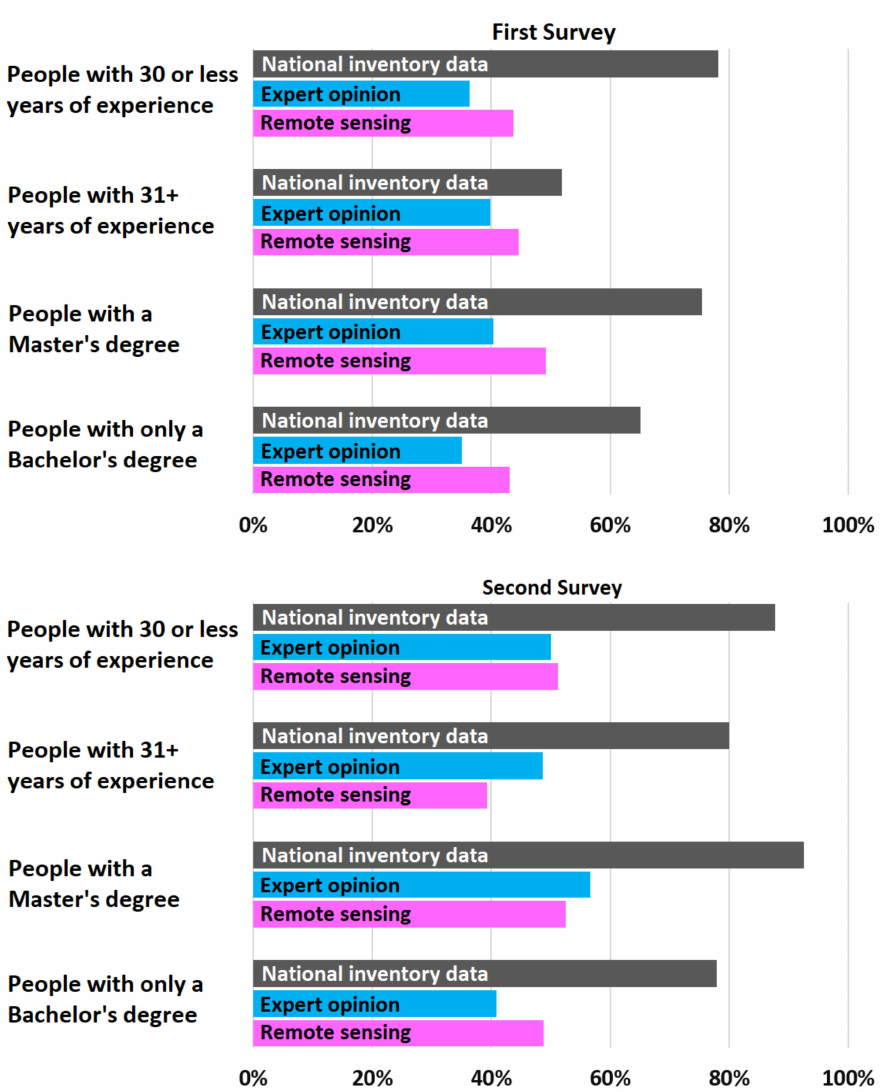
Figure 4. Percentage of respondents in different demographic groups who supported updating the maps using national inventory plot data, expert opinion, and/or remote sensing